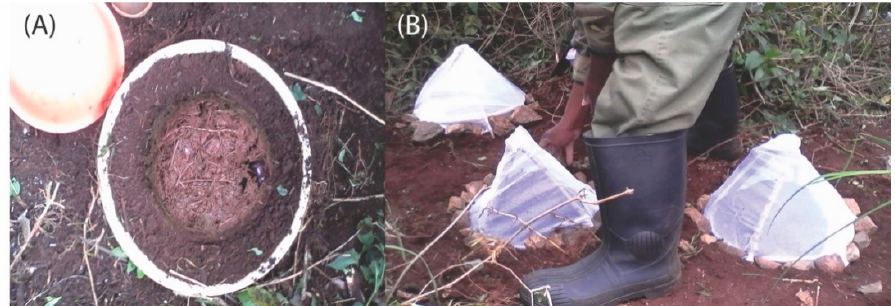
Figure 1. Experiment design: ( A ) a 1-L dung pat placed on top of a soil filled bucket and ( B ) pyramidal structures containing dung pats.